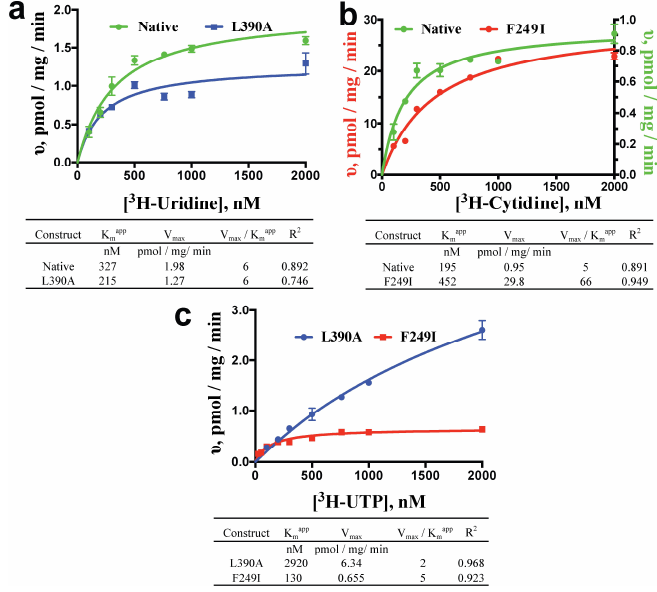
Figure 2. Kinetics of [ 3 H]-uridine ( a ), [ 3 H]-cytidine ( b ), and [ 3 H]-UTP ( c ) by Native and Mutant ScENT1-containing PLs. Substrate influx was measured at 10, 20, 50, and 60 min using